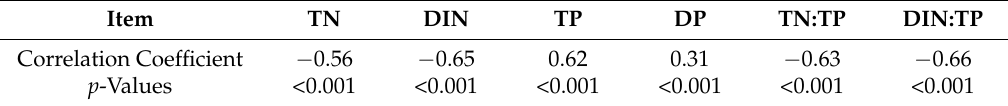
Table 1. Correlations between concentration of cyanobacteria and TN, DIN (dissolved inorganic nitrogen), TP, DP (dissolved phosphorus), TN:TP, and DIN:TP in Lake Vombsjön, and resulting p -values (Spearman’s